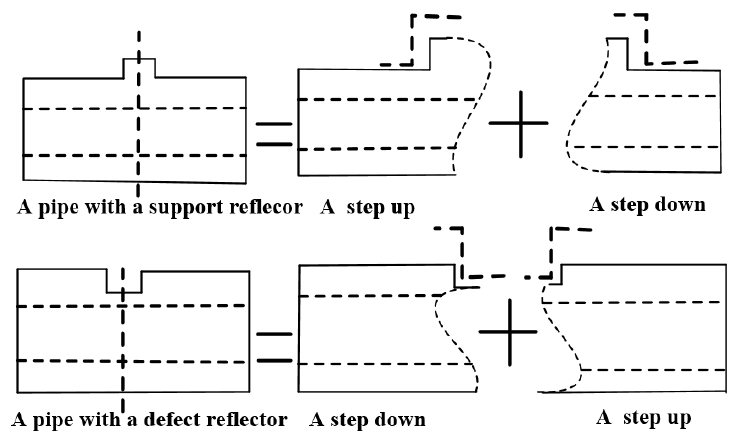
Figure 5. A reflector can be decomposed into a step down and a step up .